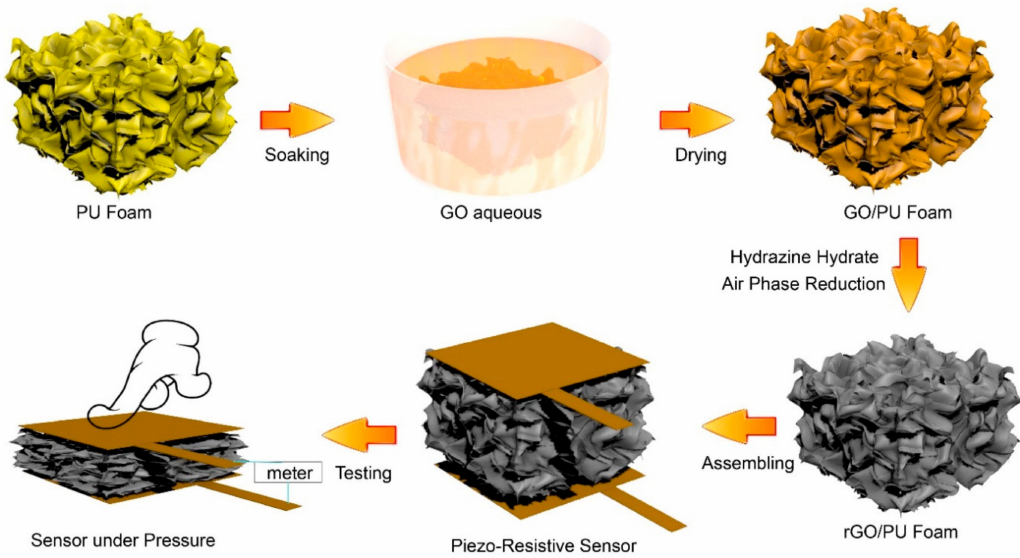
Figure 1. Schematic figure of Preparation and assembling of the reduced graphene oxide / polyurethane (rGO / PU) foam piezo-resistive